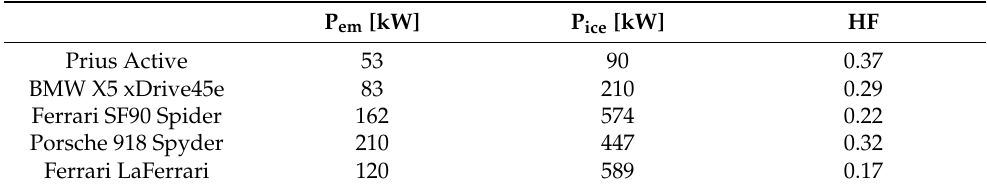
Table 1. Hybridization factor of cars on the market (source: https://www.quattroruote.it/, accessed on 27 May 2022).